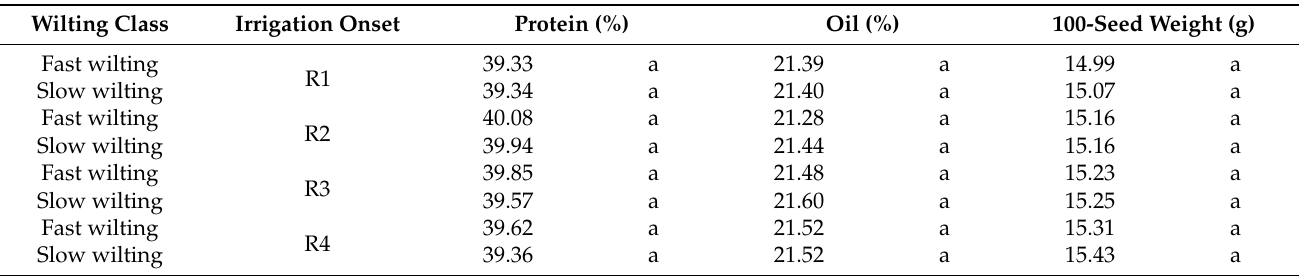
Table 3. Average soybean seed protein, oil concentration, and 100-seed weight of each wilting class under different onset irrigations (R1, R2, R3, and R4) evaluated in four environments (location-year combination 19ROH, 19STU, 20ROH, and 20STU). Values with same letters are not significantly different (Tukey’s; p -value <